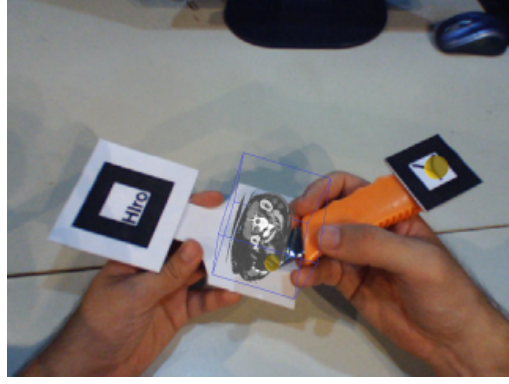
Fig. 7. Bimanual, multimodal user interaction in the AR